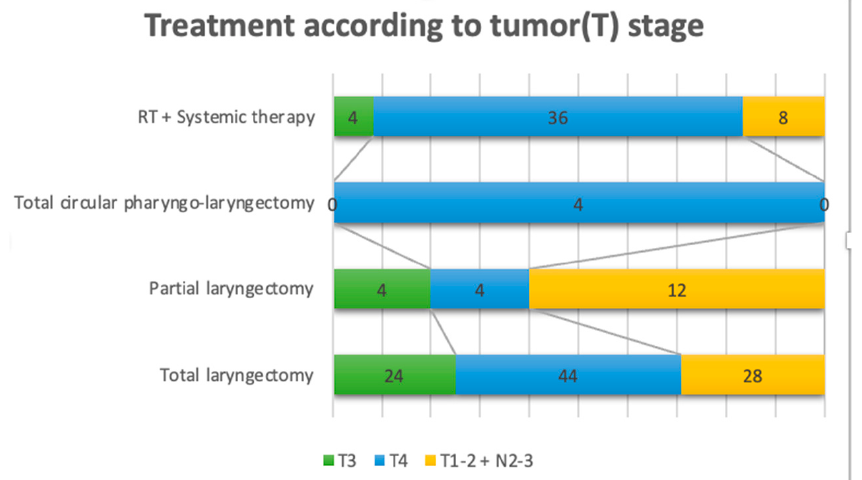
Figure 7. Treatment according to tumor stage.